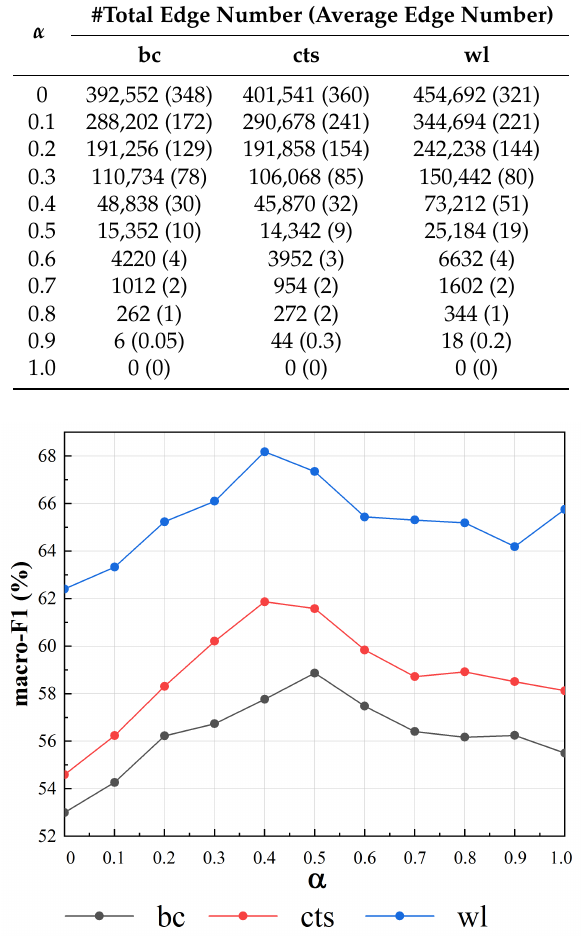
Figure 9. Macro-F1 values with different values of α